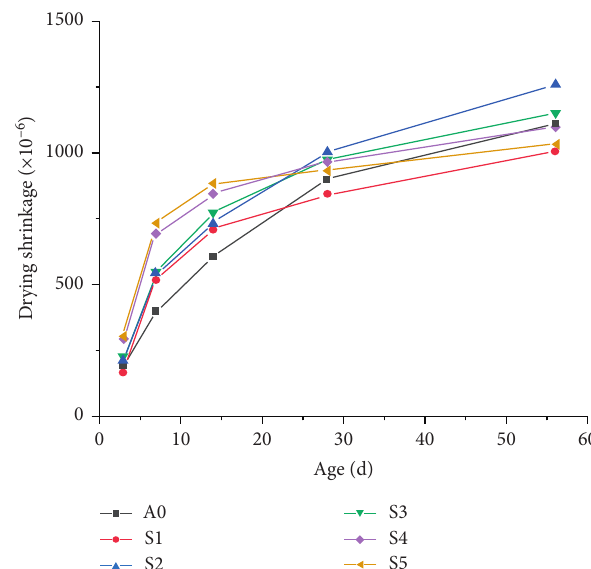
Figure 4: Effect of SF on AAM drying shrinkage.